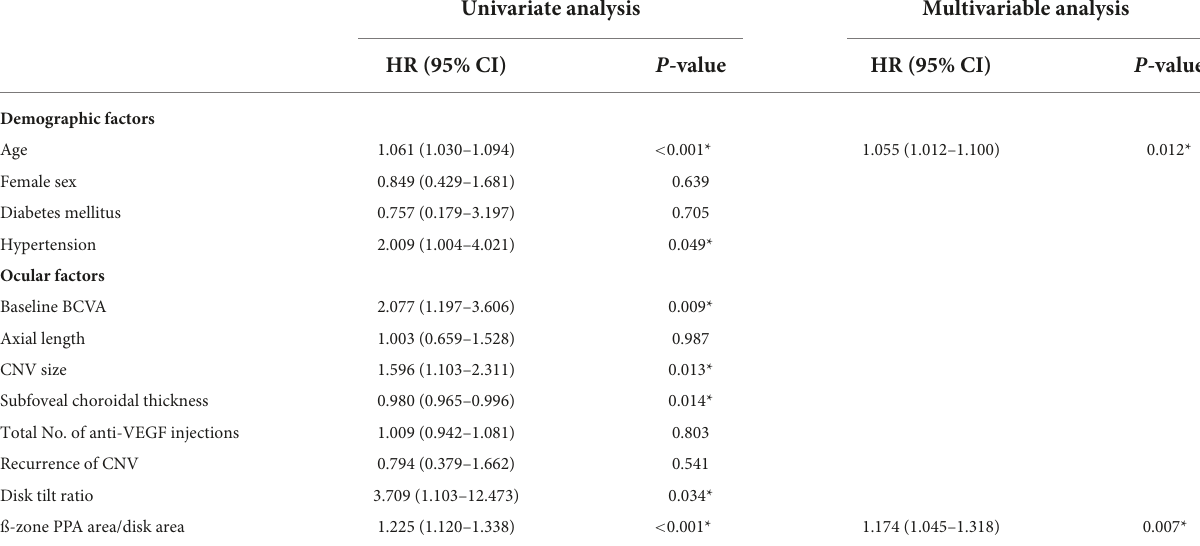
TABLE 5 Baseline characteristics associated with poor visual outcomes in eyes with myopic choroidal neovascularization. Univariate